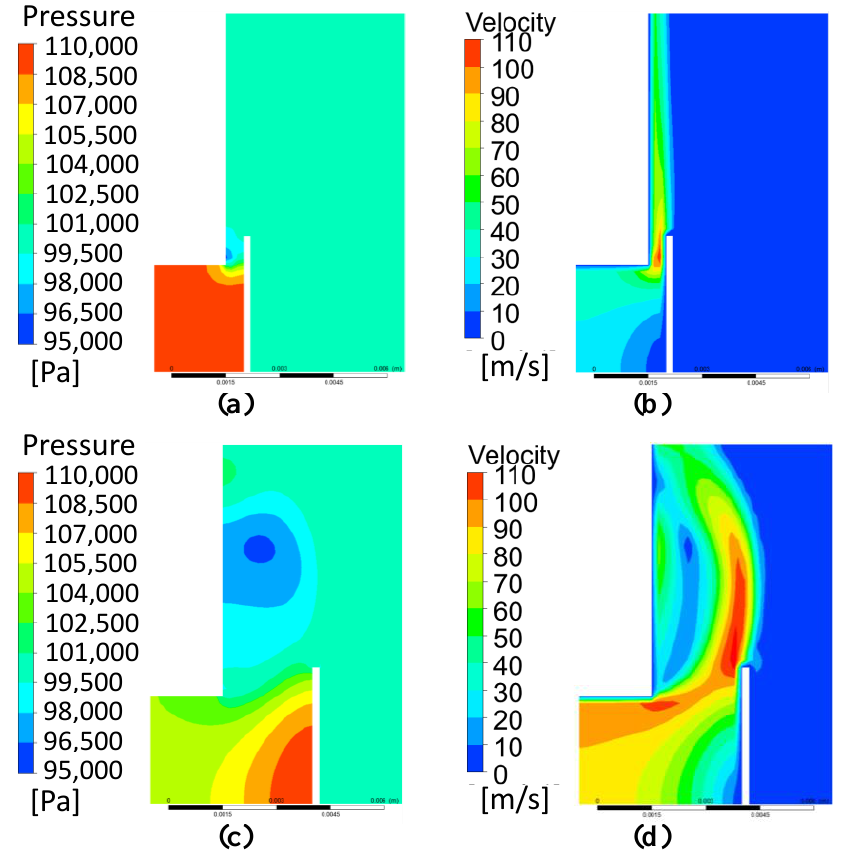
Figure 5. Pressure and velocity distributions ( p in =110 kPa, p out = 100 kPa, R P = 3.0 mm, R V = 3.8 mm): ( a , b ) valve lift = 0.5 mm; ( c , d ) valve lift =2.0 mm.